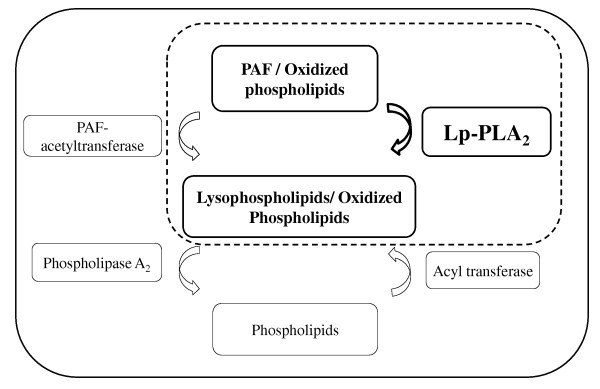
Role of Lp-PLA2 on the generation of lysophospholipids.